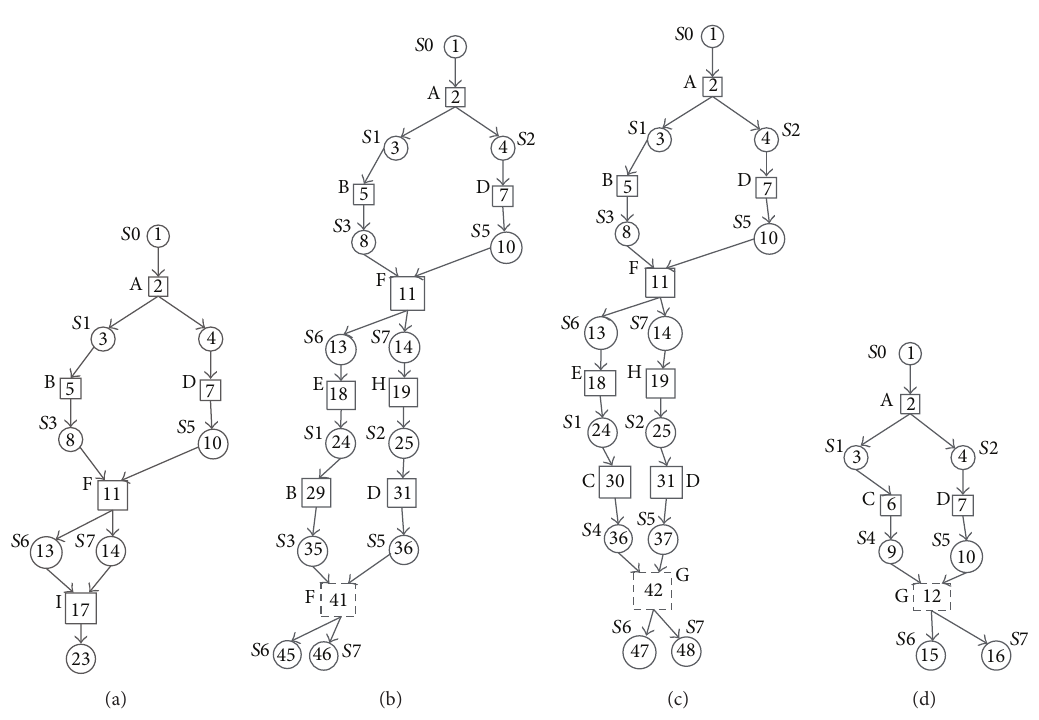
Figure 6: The set of conflict-free CFPs as decomposition of Fin Σ in Figure